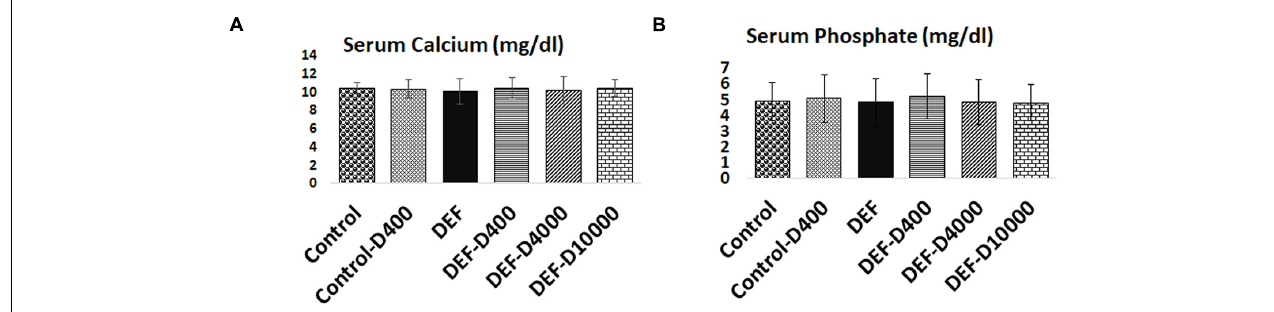
FIGURE 3 | Representation of maintained serum (A) calcium and (B) phosphate within the normal range in all the groups. D: refers to VD supplementation in different doses equivalent to 400, 4,000, and 10,000 IU. DEF: refers to VD deficiency. No statistical significance between the groups.